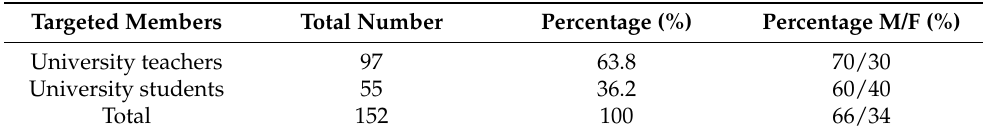
Table 3. Distribution of respondents answering the